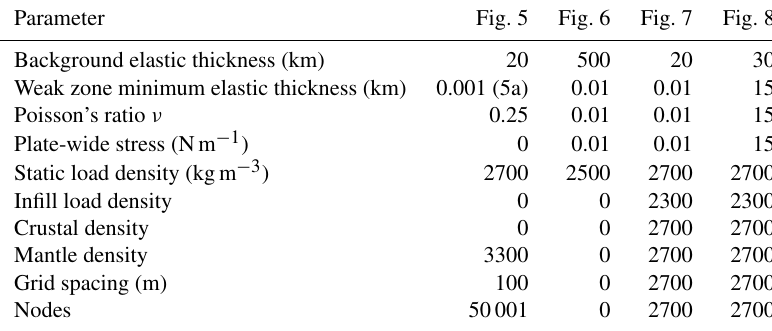
Table A1. Parameters used for Figs. 5–8.